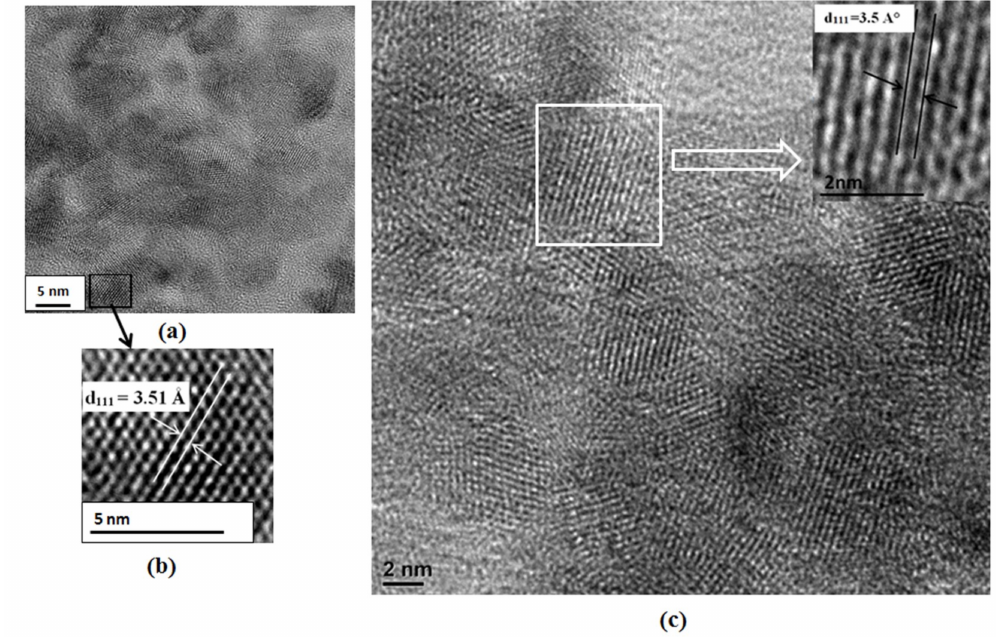
Figure 2. HRTEM images of QDs: ( a , b ) CdSe QDs and ( c ) CdSe(S)/ZnO